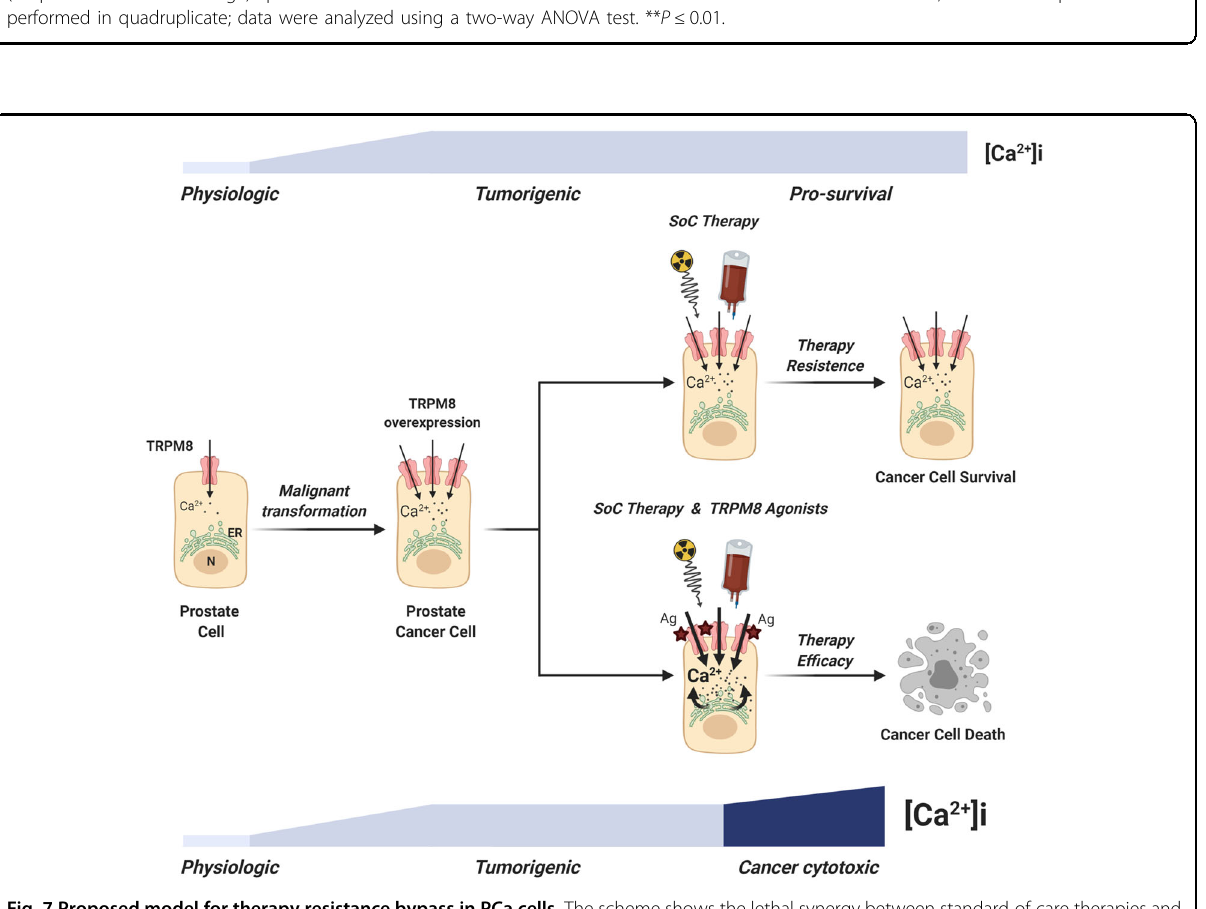
sample 25 . Normalized RNA-seq counts for TRPM8 isoforms were obtained from TCGA Legacy Archive (https://portal.